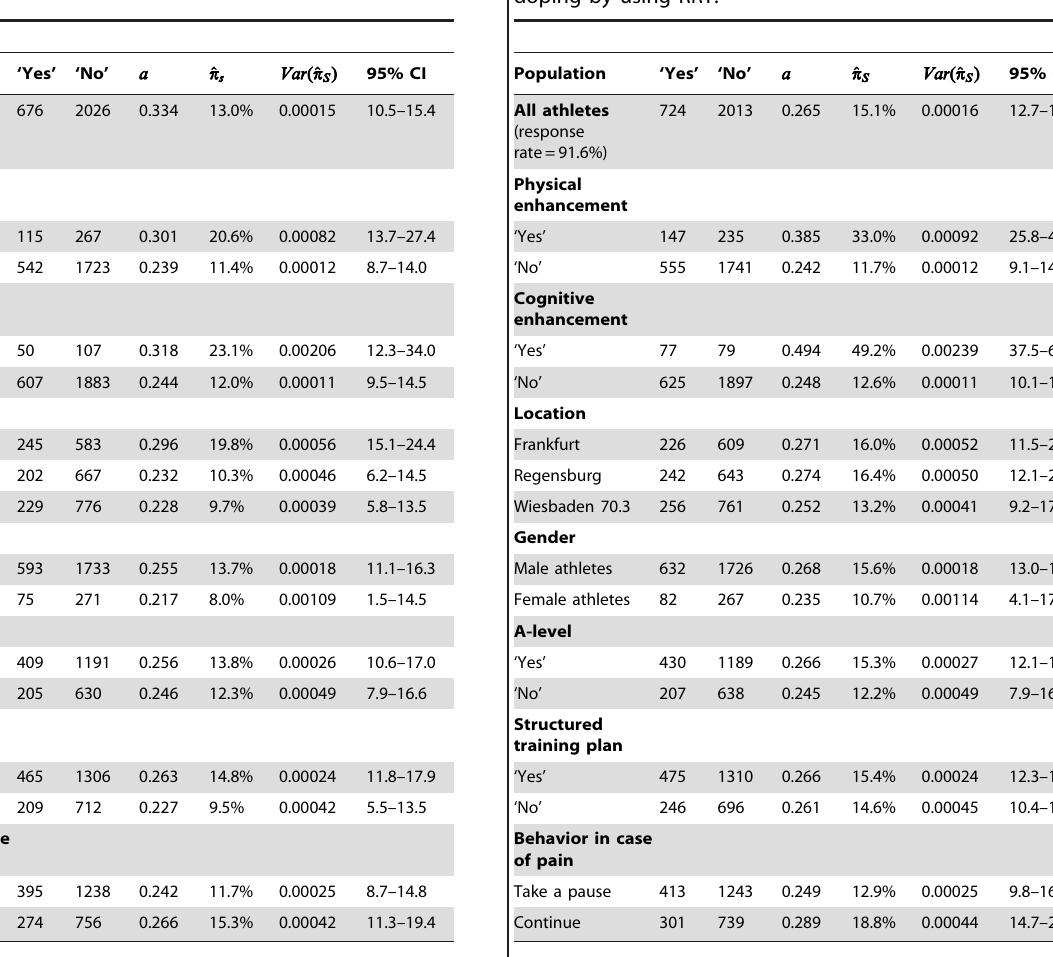
Table 9. Estimated 12-month prevalence for physical doping by using RRT.